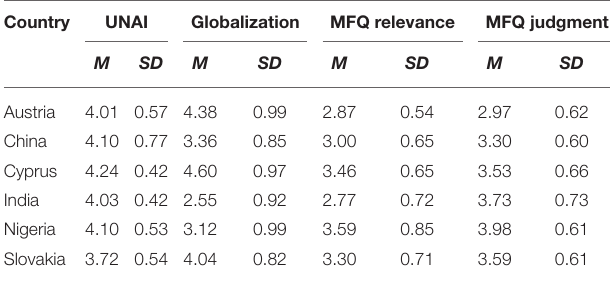
TABLE 1 | Descriptive statistics of